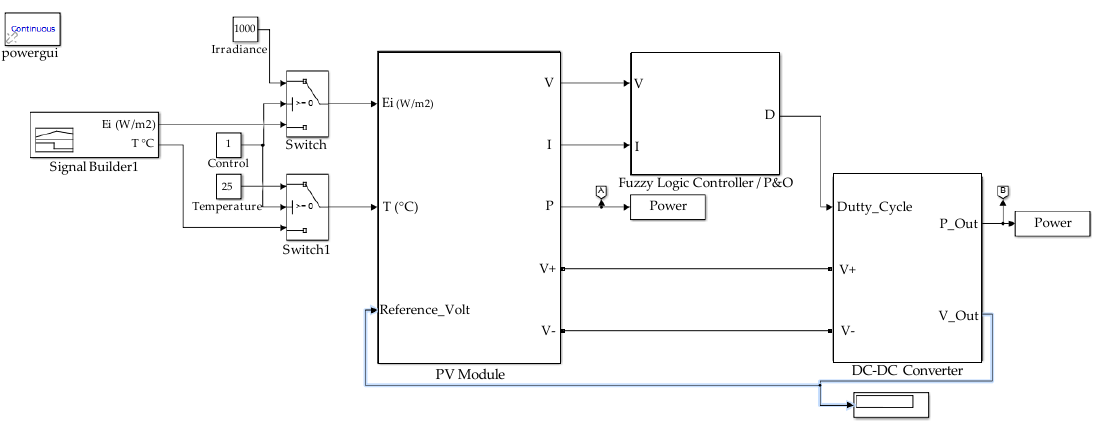
Figure 13. PV system modelling.